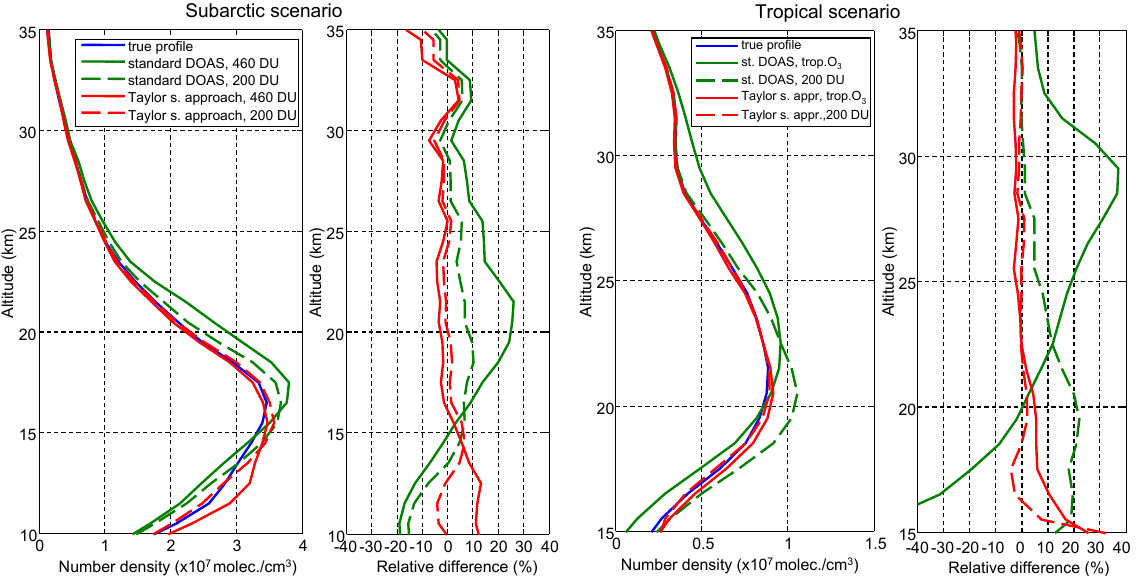
Fig. 8. Retrieved concentration profiles of BrO from simulated spectra by the standard DOAS and Taylor series approach (first and third panel from left) and the relative differences with the true profile (second and fourth panel). Left panels: Result for the subarctic atmospheric scenario where besides the simulation of spectra using the ozone profile with VCD=460DU also a simulation for an ozone profile scaled to VCD=200DU is performed. Right panels: Result for a tropical scenario with a tropical ozone profile with the maximum at 28km and also for a subarctic profile (scaled to 200DU) with the peak at